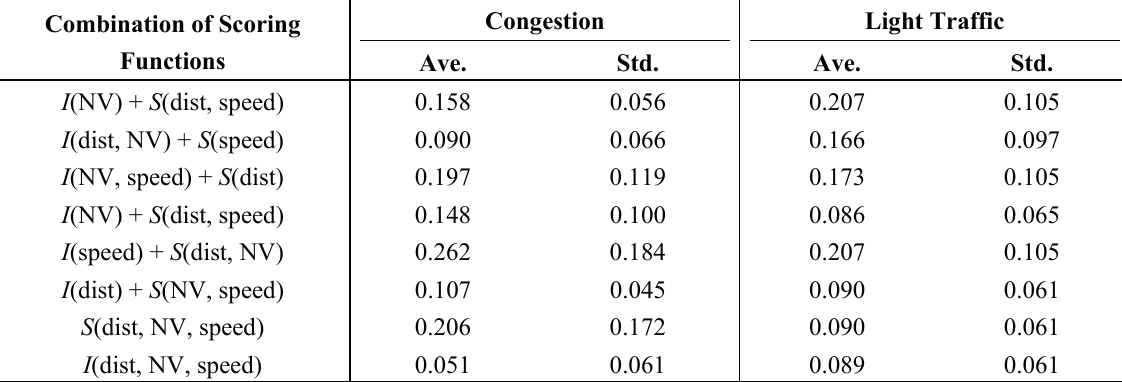
Figure 9. Cumulative error for various combinations of scoring functions ( a , b ) and weight values ( c , d ). (( a , c ) Congested traffic, ( b , d ) light traffic.) Table 9. Average error rate for combinations of scoring functions under the congestion and light traffic